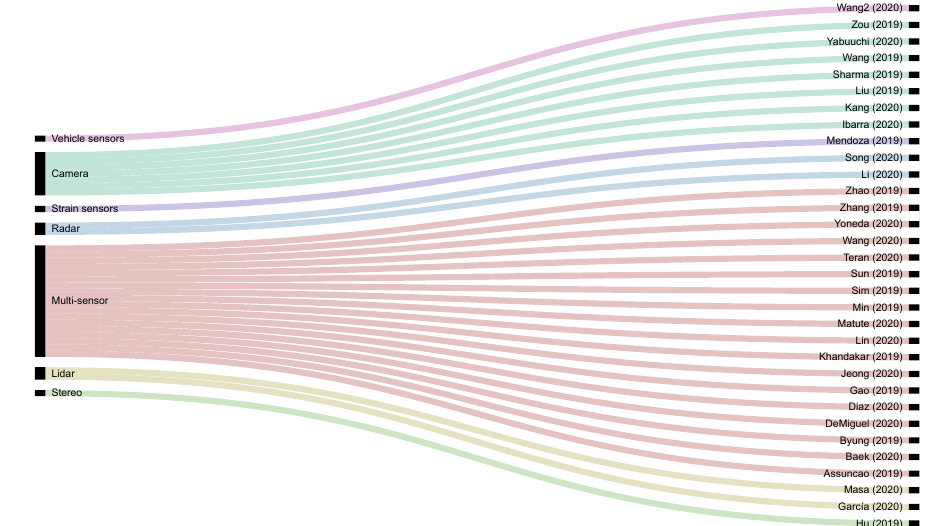
Figure 4. Alluvial diagram showing the correlation between the sensors and the